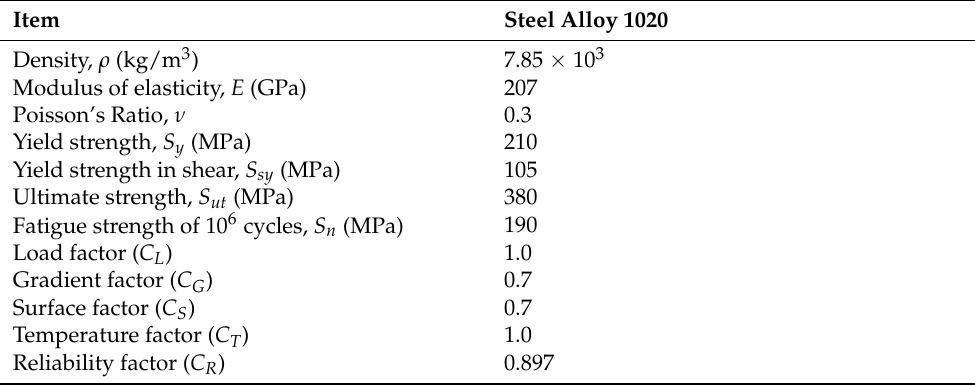
Figure 3. ( a ) The shape of transplanting device, ( b ) 4-bar mechanism of transplanting device of the 4-bar link type semi-automatic vegetable transplanter. Table 2. Mechanical properties and modifying factors of Steel alloy 1020.